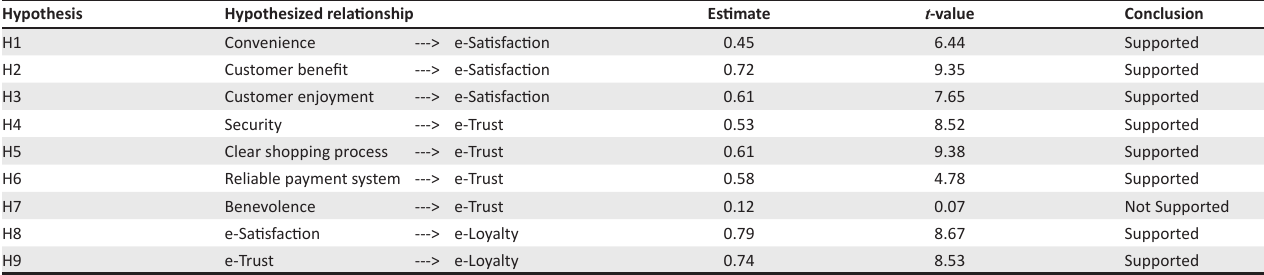
TABLE 5: The results of structural equation model.